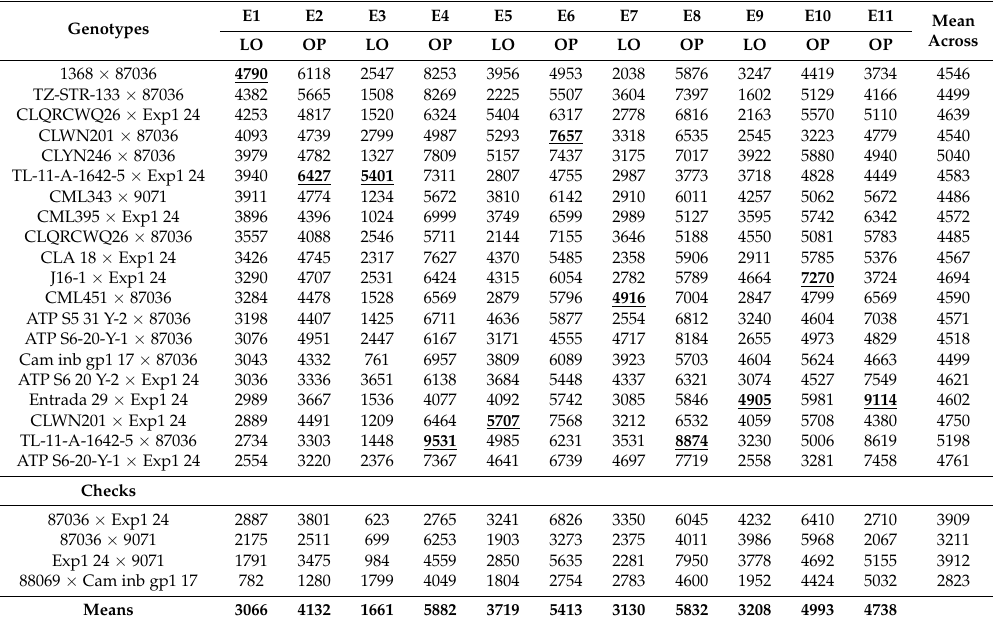
Table 5. Mean grain yield (kg ha − 1 ) of 20 hybrids and four checks across 11 environments in Mbalmayo and Nkolbisson in 2012 and